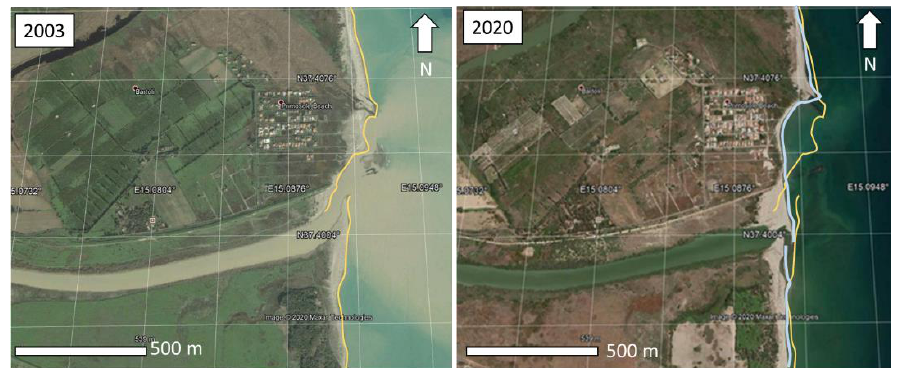
Figure 7. Retreat of the Simeto river mouth on the Catania coastal plain. The shoreline at 2003 epoch is marked in light orange ( left ) while the shoreline for 2020 epoch is marked in light blue ( right ). lower than 35% (Figure 8). Below are reported the estimated shoreline changes for a set